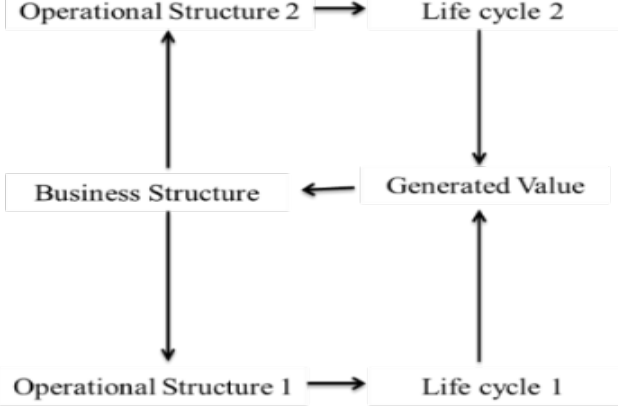
Figure 2. Risk management